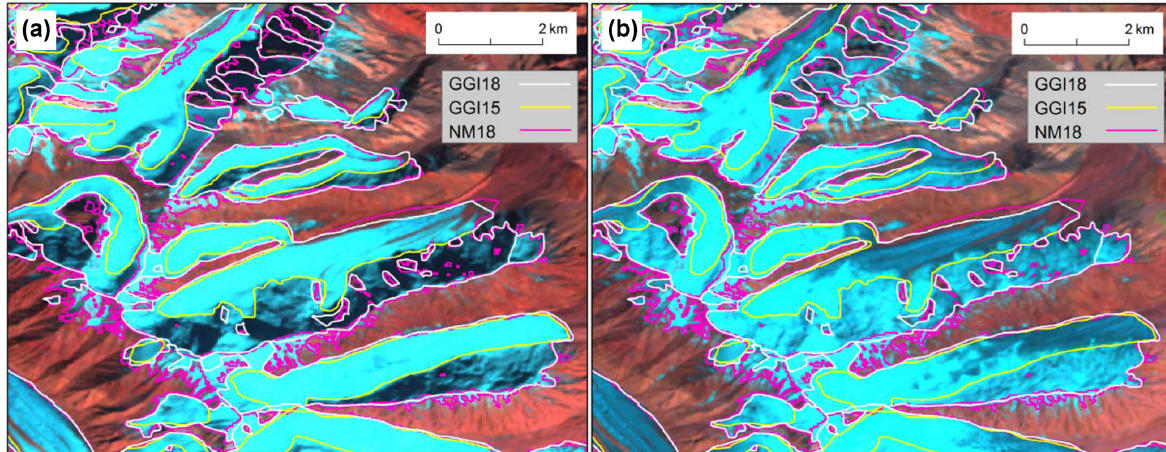
Figure 2. Comparison of glacier outlines used in the GGI15, GGI18, and NM18 inventories at 38.9236 ◦ N, 72.4217 ◦ E (path 151, row 33 of WRS2). Backgrounds are false-colour (bands 7, 4, and 2 as RGB) composite Landsat images taken on 28 September 2001 (a) and 26 July 2001 (b) . Glacier outlines of the GGI15 (yellow lines) were delineated based on the strongly shaded image on the left, whereas those of the GGI18 (white lines) were delineated using the less-shaded image on the right. Glacier outlines of the NM18 (pink lines; Mölg et al., 2018) are also shown for